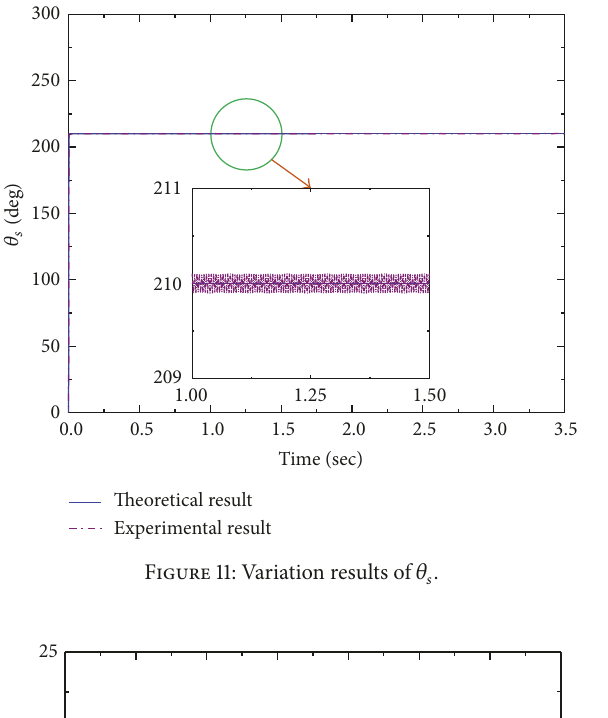
Figure 11: Variation results of 𝜃 𝑠 .